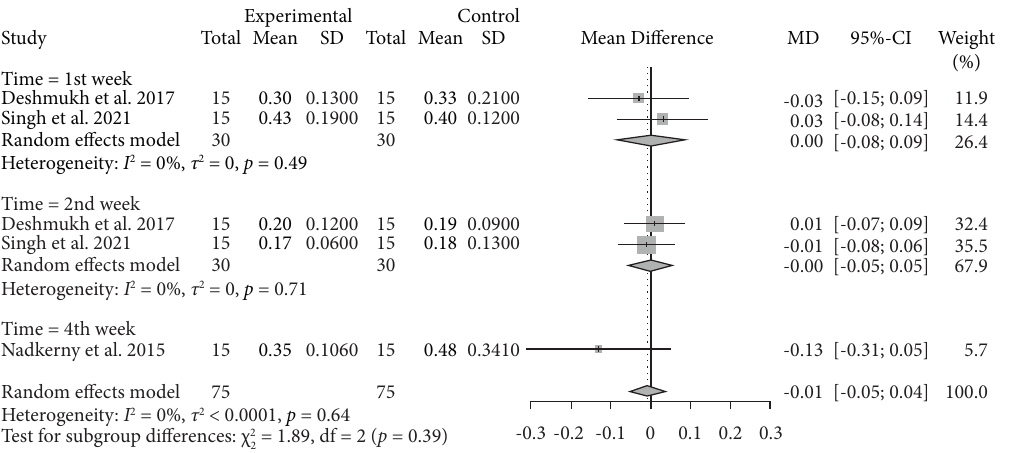
Figure 6: Forest plot for the oral hygiene index (experimental: probiotics and control: